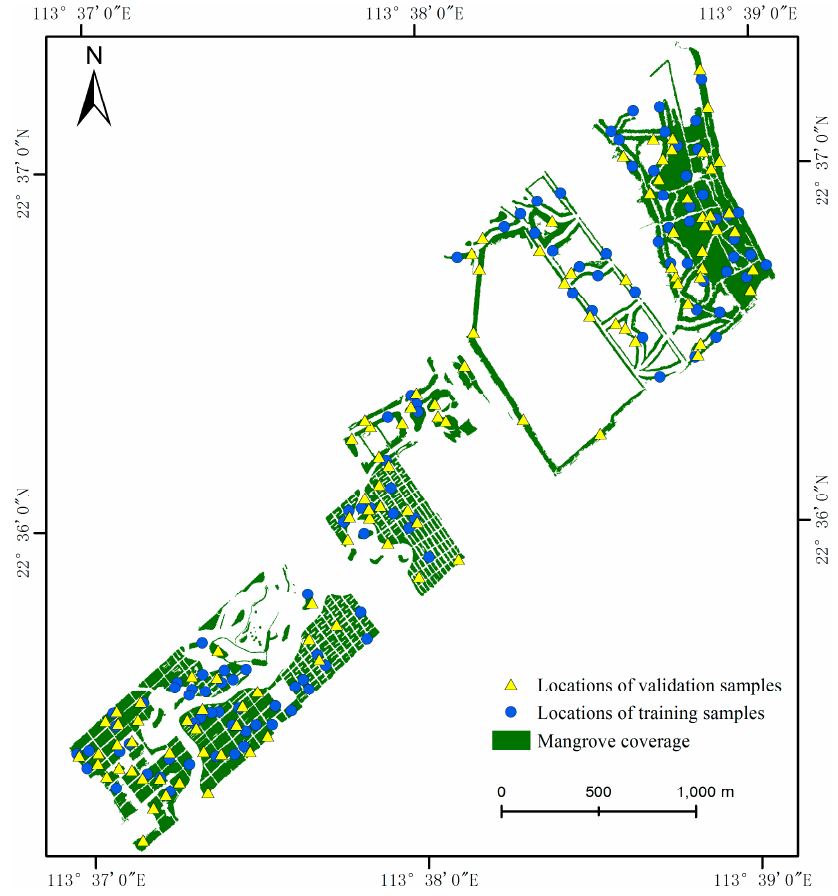
Figure 2. The location of field samples available for training and validation purposes. Table 1. Number of training and validating samples for each mangrove species.